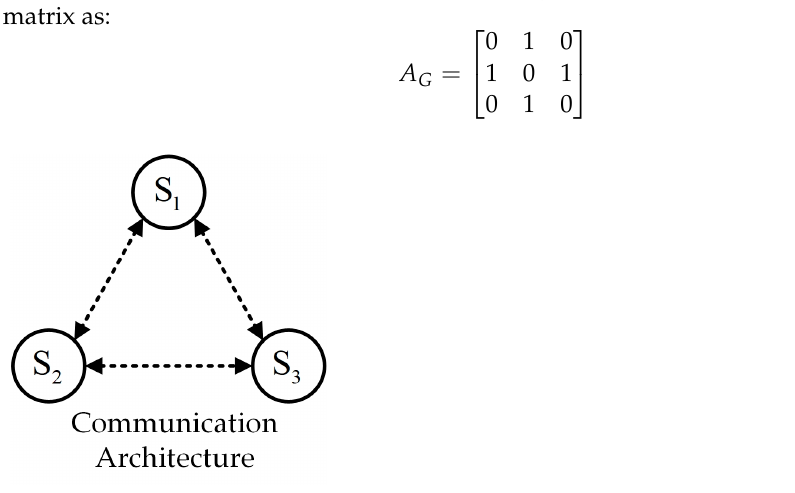
Figure 11. Bidirectional ring network communication structure for the DC microgrid with ESSs.